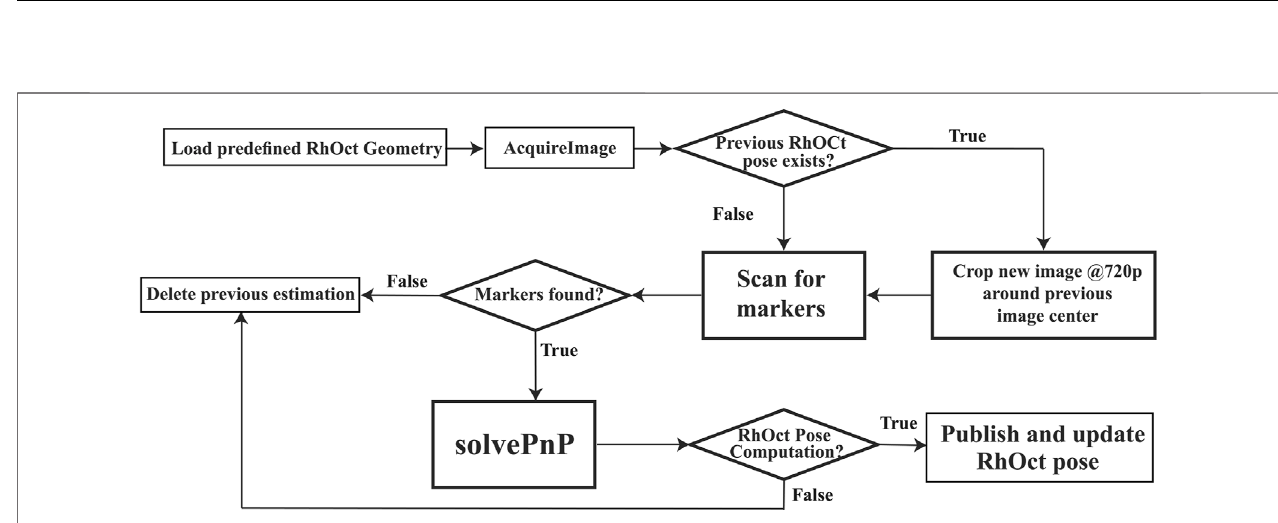
FIGURE 4 | Flowchart of RhOct pose estimation